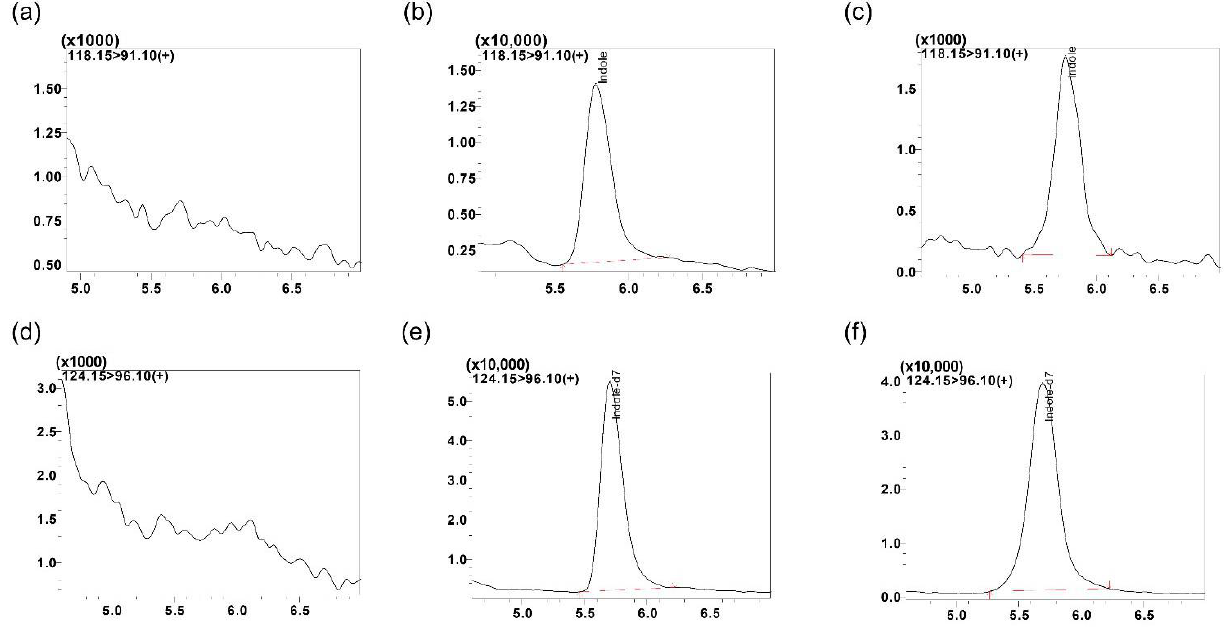
Figure 2. Representative MRM ion-chromatograms of ( a ) blank mouse lung homogenate using the conditions for indole detection, ( b ) indole spiked in mouse serum at 10 ng/mL (rt. 5.8 min), ( c ) indole mouse lungs homogenate study sample (rt. 5.8 min, Id: AI-2), ( d ) blank mouse lung homogenate using the conditions for indole-d7 detection, ( e ) indole-d7 spiked in mouse lung homogenate (rt. 5.8 min, 200 ng/mL) and ( f ) indole-d7 spiked in mouse study lung homogenate sample (Id: AI-2).